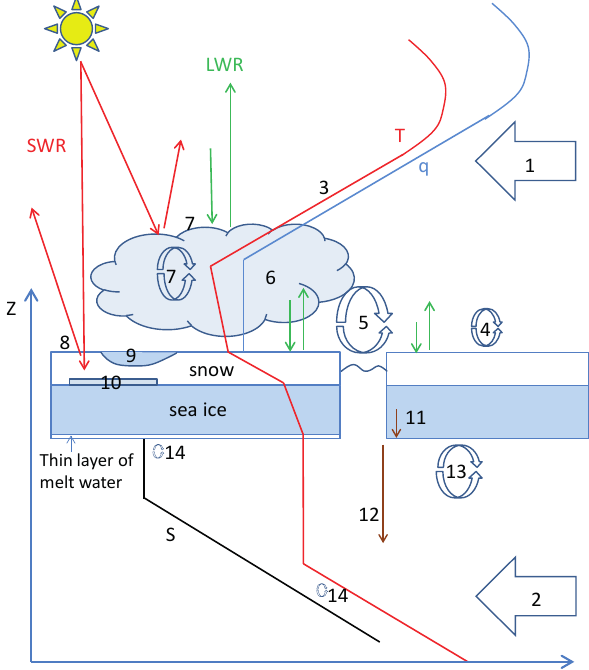
Increasing temperature (T), speci fi c humidity (q), and salinity (S) Figure 1. Simplified presentation of physical processes and verti- cal profiles of temperature ( T ), air humidity ( q ), and ocean salinity (S) in the marine Arctic climate system. In reality, the shape of the profiles varies in time and space. The numbers indicate the follow- ing processes: 1 – atmospheric advection of heat and moisture to the Arctic; 2 – oceanic advection of heat and salt to the Arctic; 3 – generation of temperature and humidity inversions; 4 – turbulence in stable boundary layer; 5 – convection over leads and polynyas; 6 – cloud microphysics; 7 – cloud–radiation–turbulence interactions; 8 – reflection and penetration of solar radiation in snow/ice; 9 – sur- face melt and pond formation; 10 – formation of superimposed ice and snow ice; 11 – gravity drainage of salt in sea ice; 12 – brine for- mation; 13 – turbulent exchange of momentum, heat and salt during ice growth; and 14 – double-diffusive convection. More detailed il- lustration of small-scale processes is given in Figs.